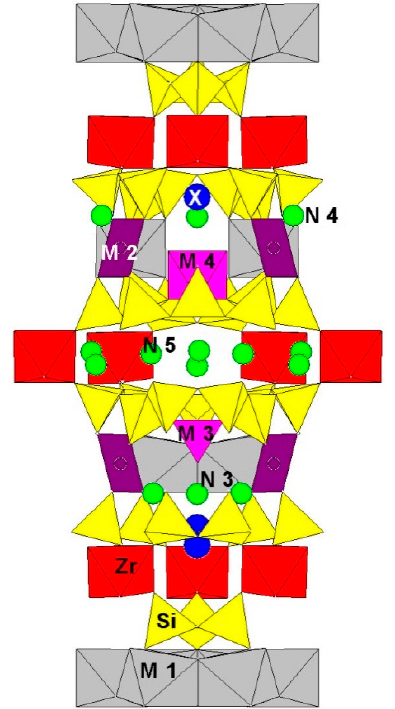
Figure 1. Arrangement of key sites in the eudialyte-type structures viewed along (210).